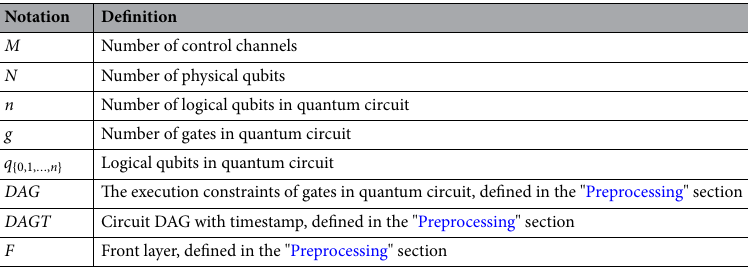
Table 2. Definition of